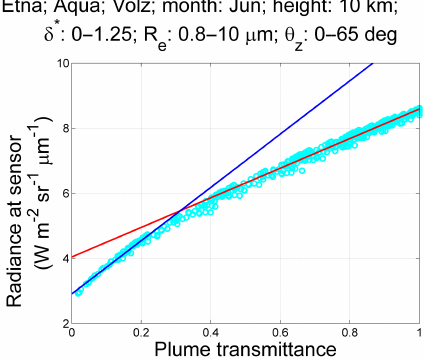
Figure 3. Radiances at the sensor (11µm) vs. plume transmittances (cyan circles) with the two linear fits of Eq. (1) for the more trans- parent part of the plume (upper fit, red line) and Eq. (2) for the most opaque part of the plume (lower fit, blue